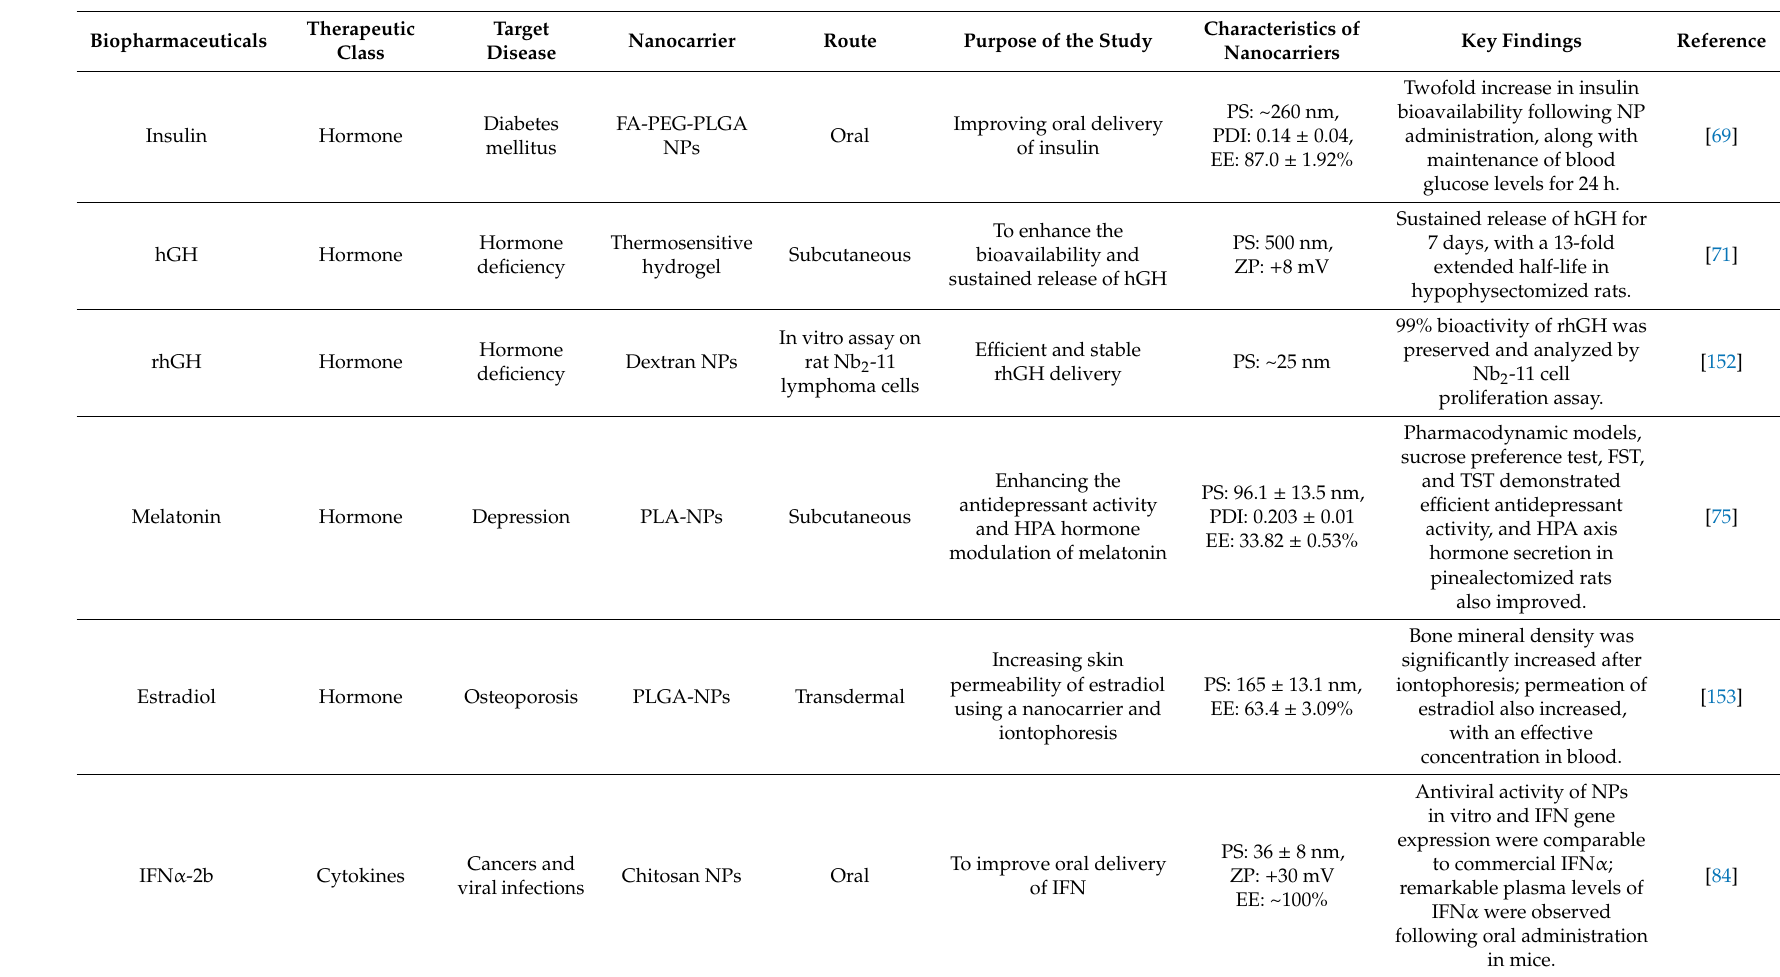
Table 2. Applications of nanocarriers in biopharmaceutical